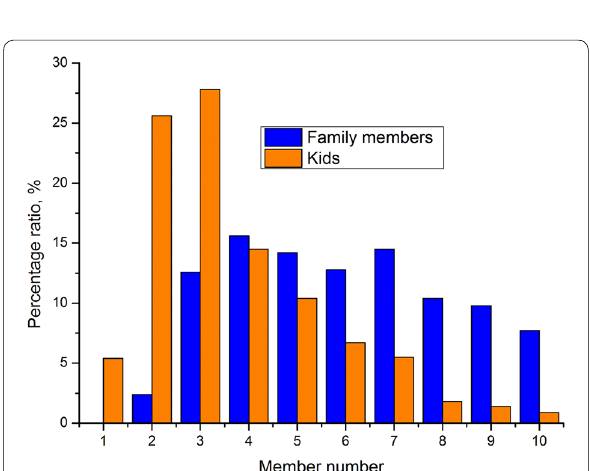
Fig. 8 The overall level of satisfaction in residents of Al Ain Faydah and Al Watani housing complexes measured based on the total number of surveyed